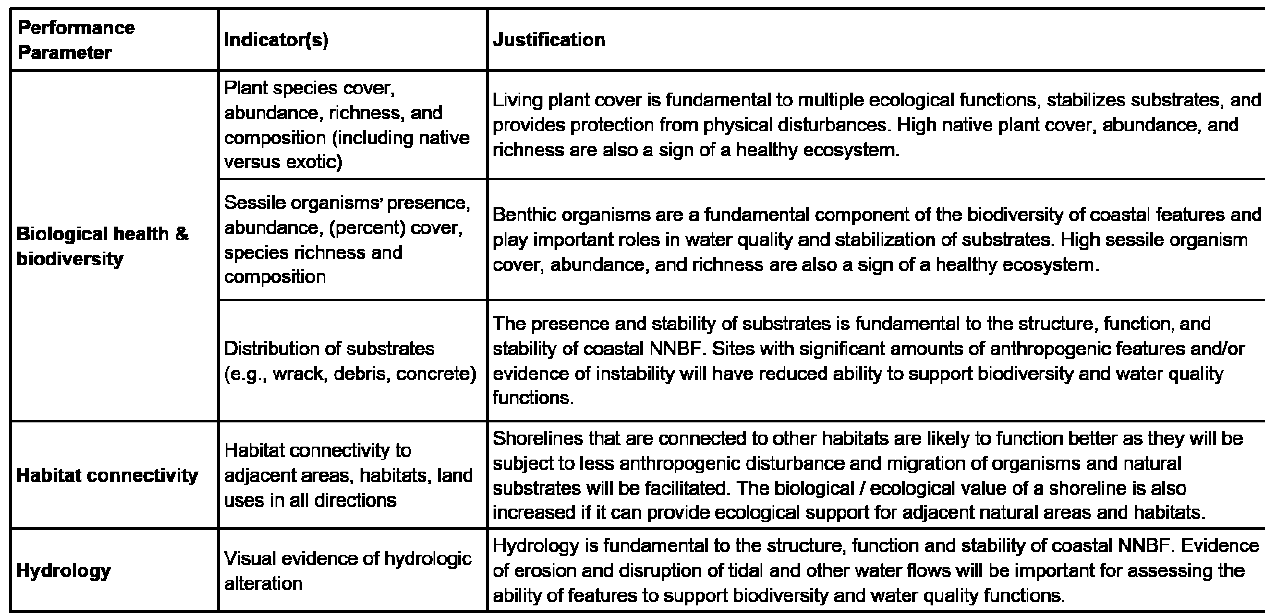
Fig. 7 . Field-tested performance parameters and indicators for ecological